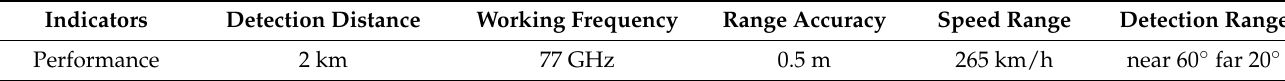
Table 1. Radar performance indicators.